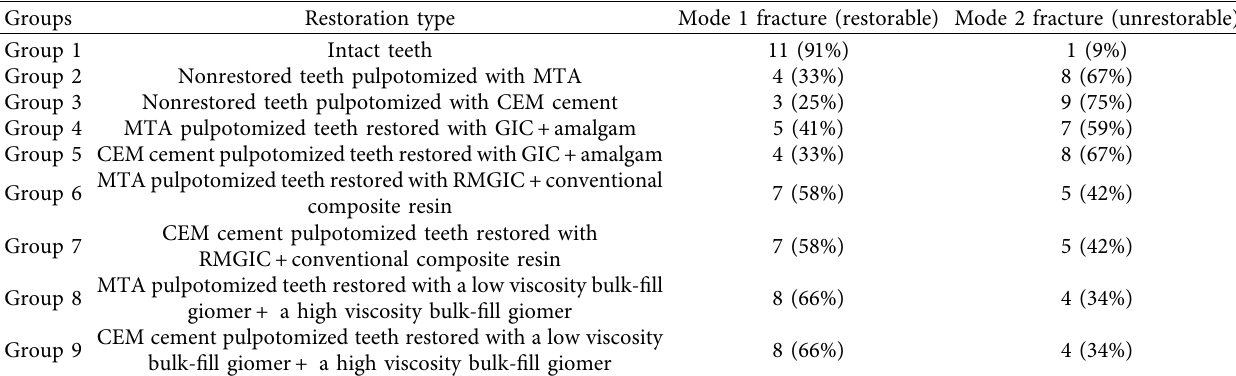
Table 2: The frequency (%) of failure modes among the experimental groups ( n �